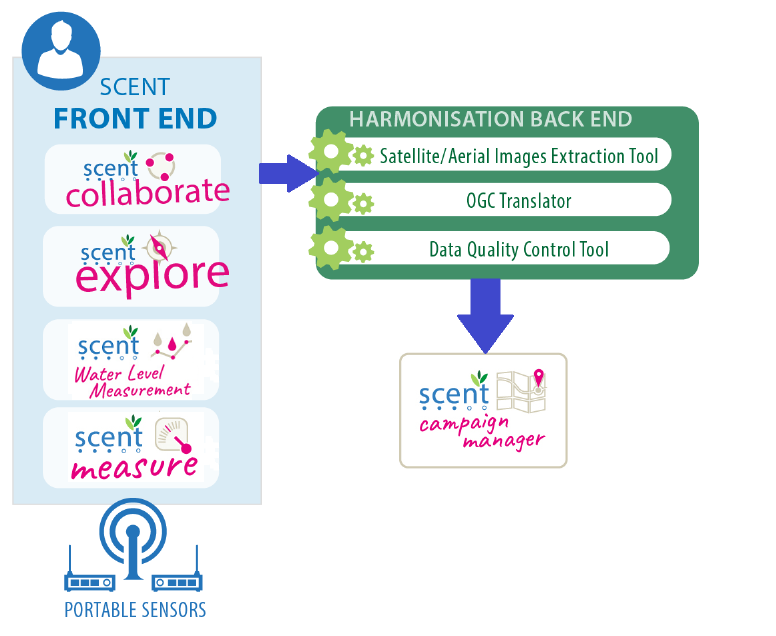
Figure 1. Scent toolbox